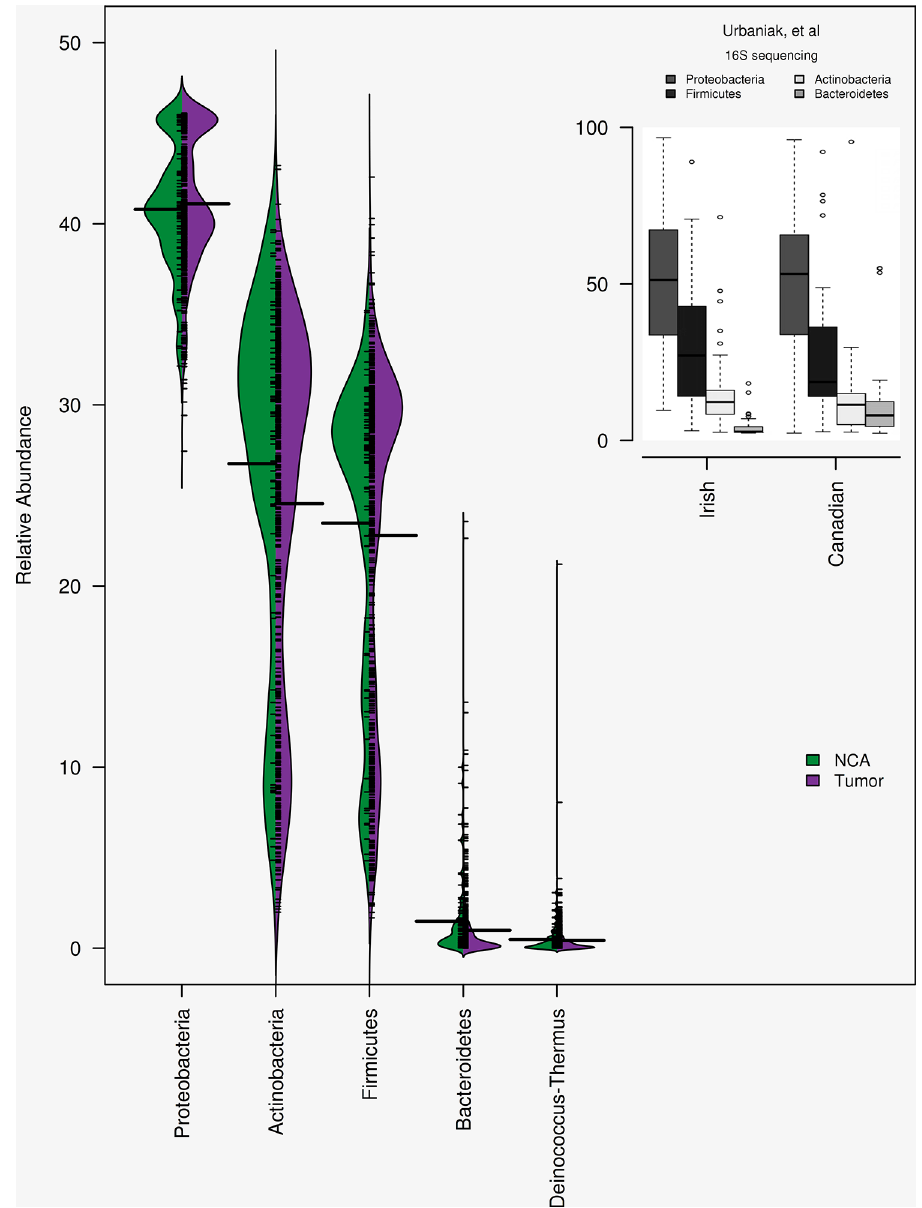
Fig 2. Phylum compositions of the tumor and NCA tissues. The most prevalentphylum in the breast microbiotais Proteobacteria , followedby Actinobacteria and Firmicutes . These observations were consistent amongeach of the tissue types (tumor shaded in purpleNCA shadedin green). These distributions are consistent with the observationsby Urbaniak, et al , see insert.